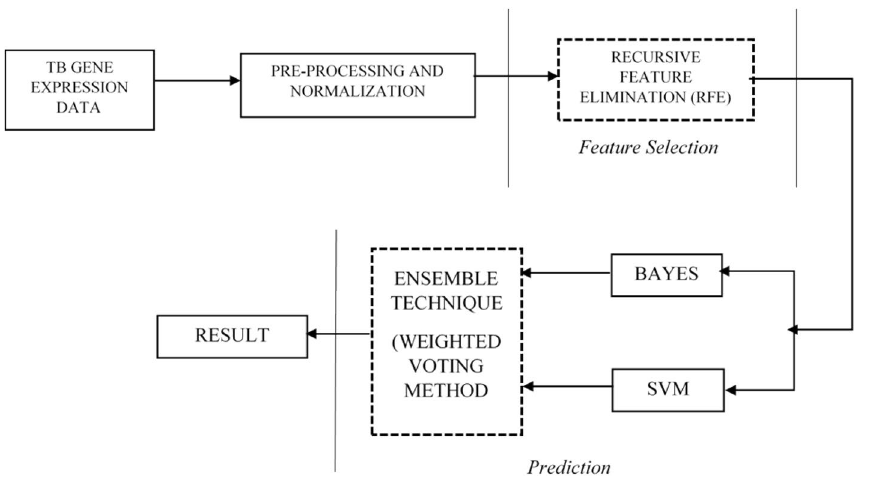
Figure 4. Model architecture for